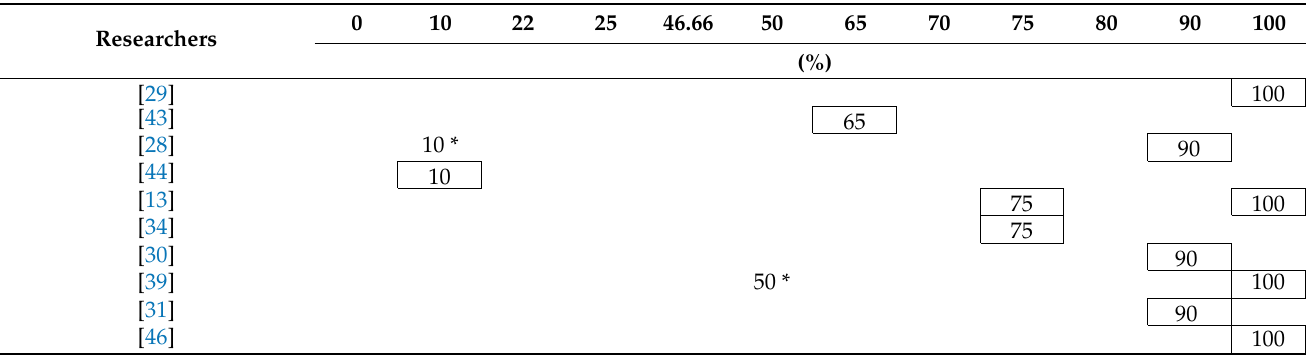
Table 4. Variation of the levels of the proportion of biomass to compose the